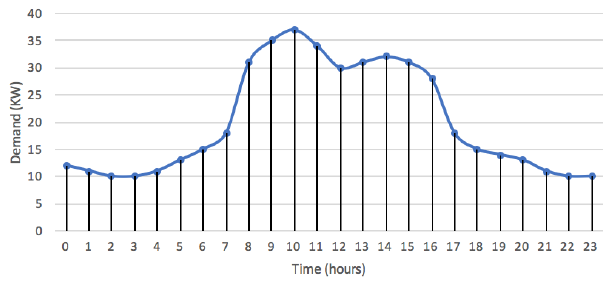
Figure 9: Energy load demand for 24-hour period, educational building, Al Baha University.